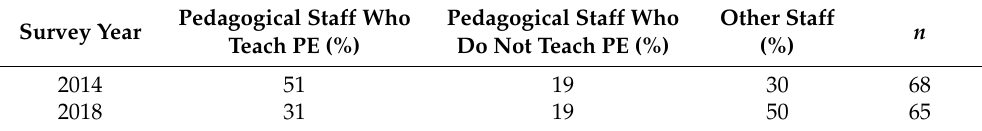
Table 1. Overview of who was responsible for conducting the PA sessions in 2014 and 2018. Survey